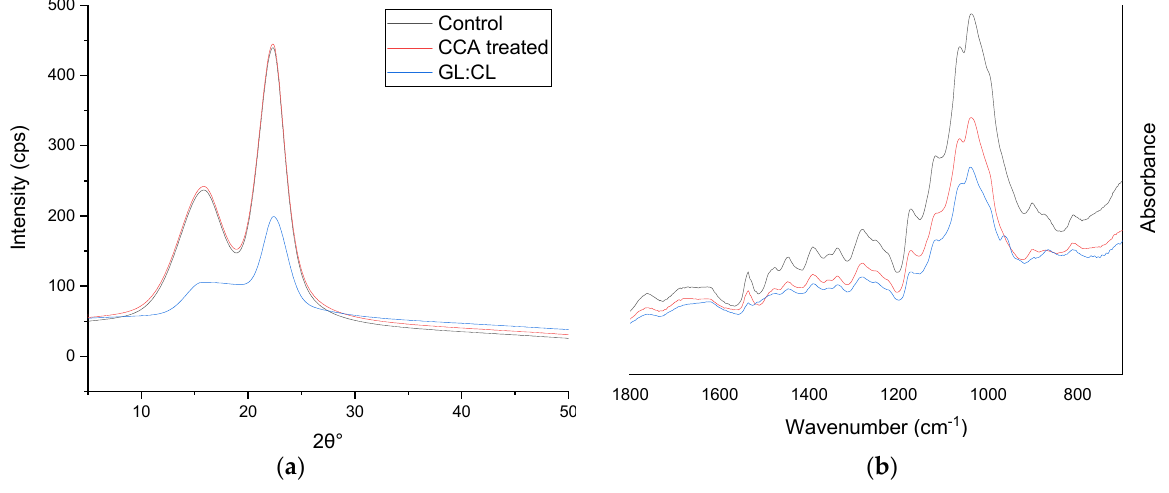
Figure 2. XRD ( a ) and FTIR ( b ) analysis results of test and control samples.